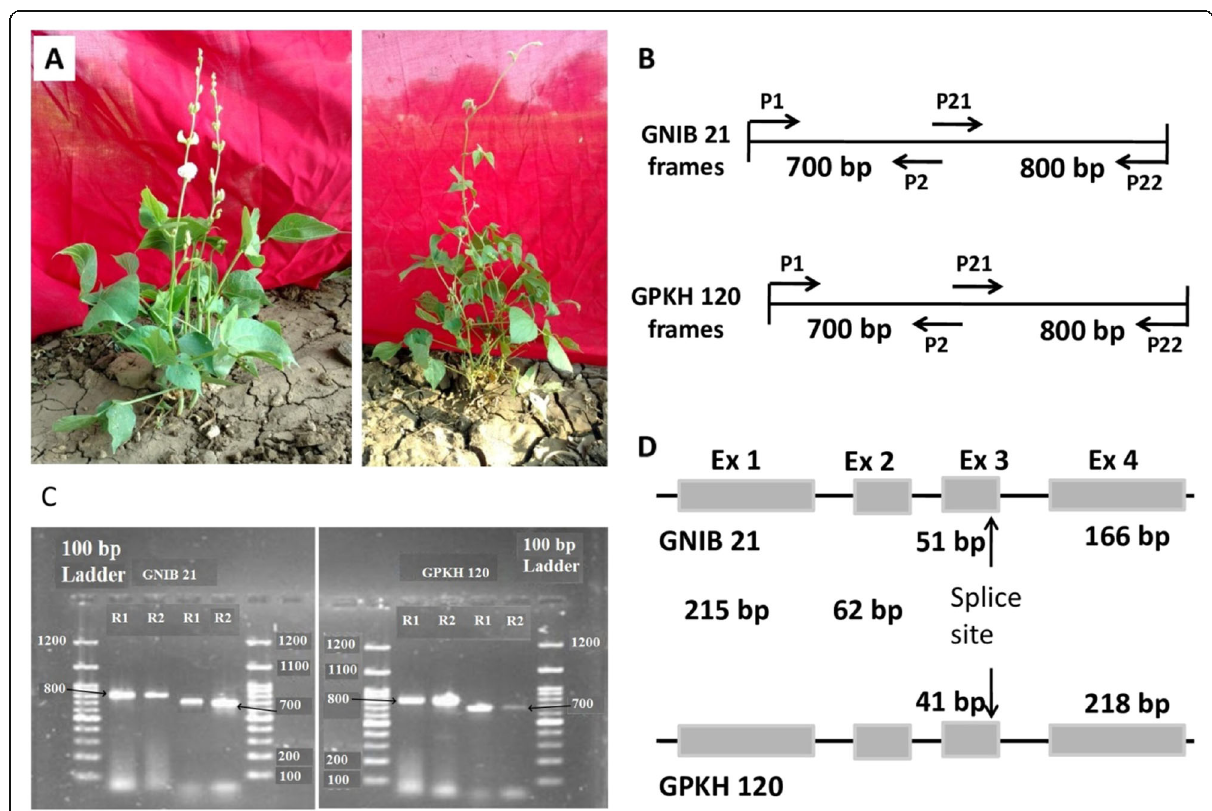
Fig. 1 Phenotypic, molecular and allelic profiling of two Indian bean genotypes. a GNIB 21 (left, determinate) and GPKH 120 (right, indeterminate). b Annealing patterns of primers designed to amplify TFL in Indian bean, P 1 and P 2 are forward and revere primers for frame1, whereas, P 21 andP 22 are for frame2. c Amplification of TFL homologue in two frames from GNIB 21 (left) and GPKH 120 (right). R1 and R2 indicate replications. Amplicon lengths have been shown by black arrows. d Gene prediction in both the genotypes indicating splice site variation at the end of the third exon (Ex)